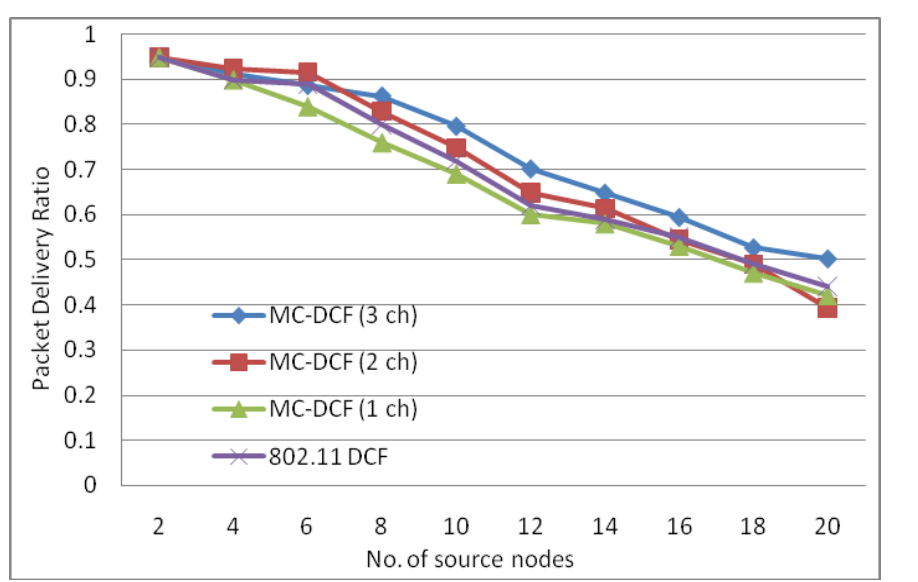
Figure 4. Delivery ratio impact from sources when using multiple sinks with single radio